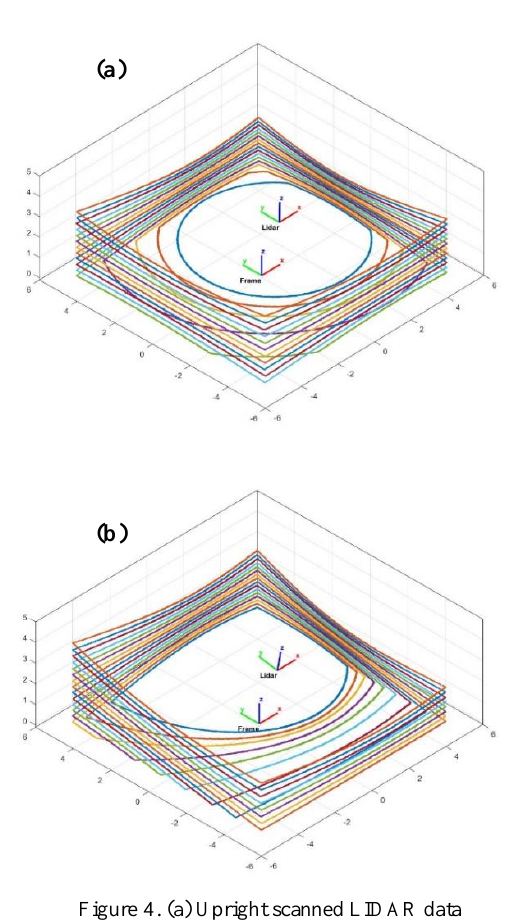
Figure 4. (a) Upright scanned LIDAR